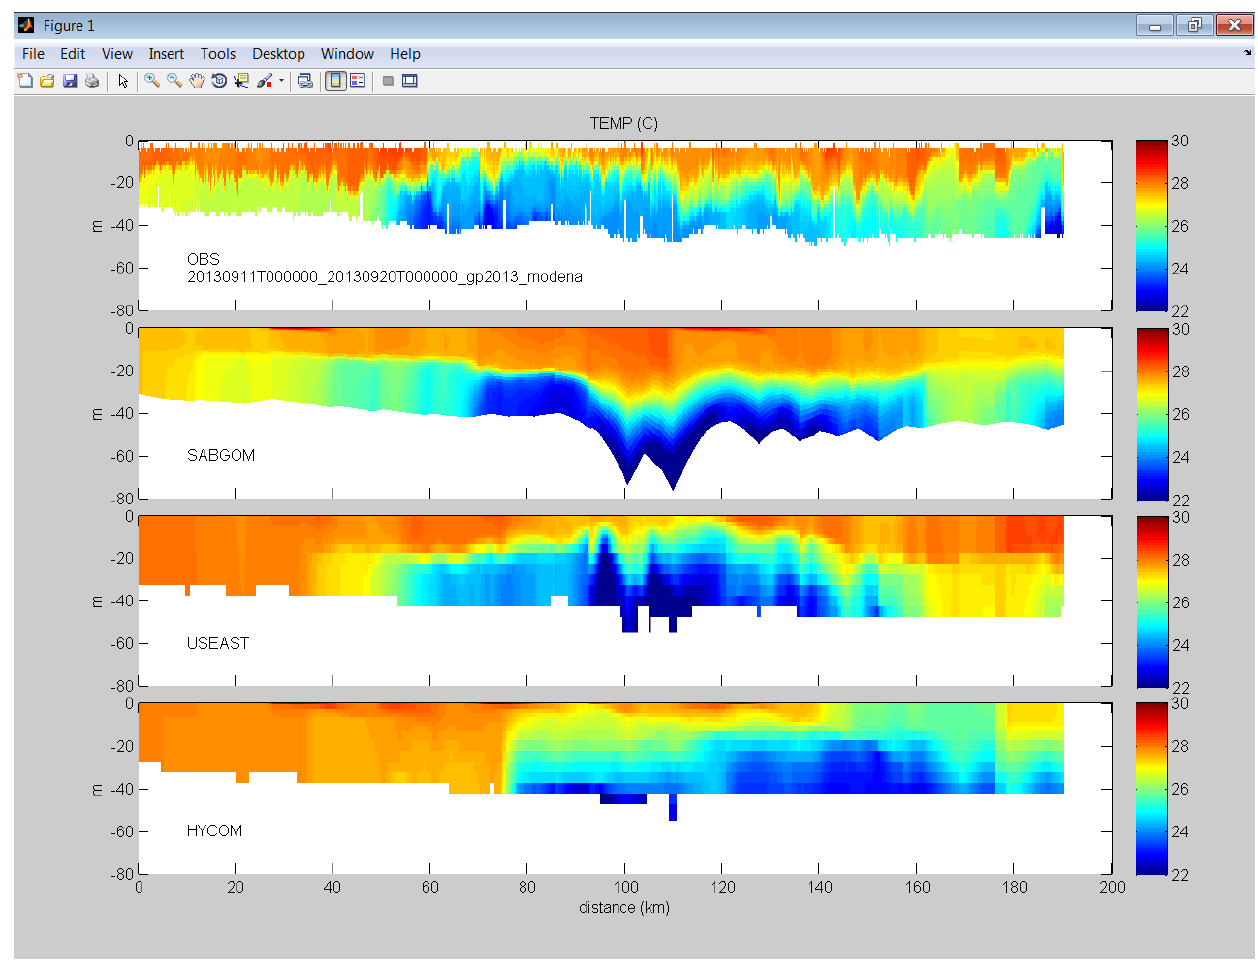
Figure 5. Comparison of ocean glider data (top panel) with forecast data from three different forecast models: the SECOORA SABGOM ROMS model from NCSTATE, the NAVY USEAST NCOM model, and the NOAA Global RTOFS HYCOM model. Tools from NCTOOLBOX were used that can extract vertical sections along time and space paths from any Climate and Forecast (CF)-compliant structured grid ocean model. The scripts that produce these plots may be found in the toolbox demos/contrib